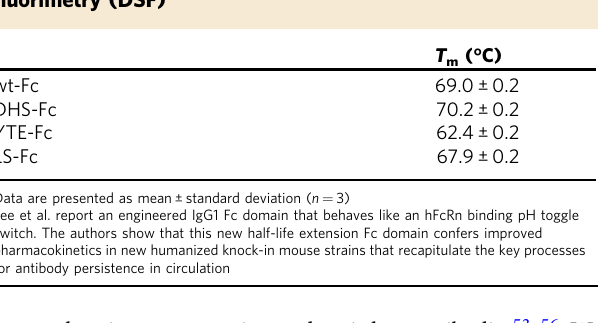
Table 5 Tm measurement by differential scanning fl uorimetry